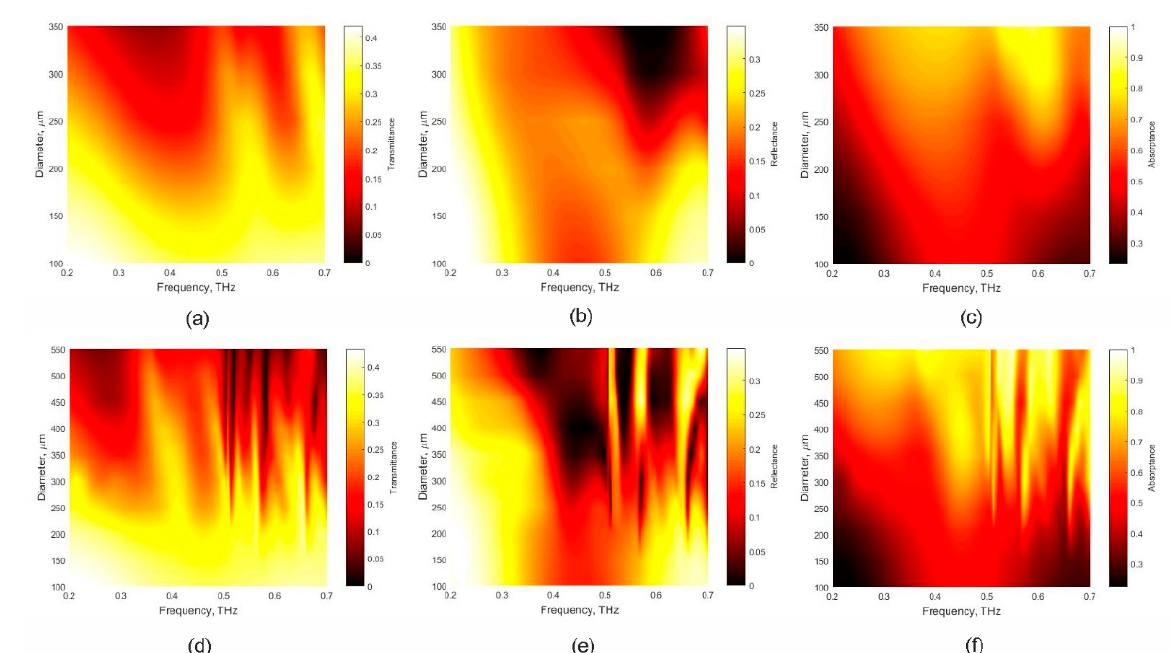
Figure 1. Transmittance ( T ), reflectance ( R ), and absorptance ( A = 1 – T − R ) of multilayer system contained the array of polymer hemispheres covered with Ni layer (30 nm thick) and deposed on SiO 2 substrate versus hemispheres diameter and frequency. The calculations were performed for the structure organized in the square lattice with 400 μ m ( a – c ) and 600 µ m ( d – f ) period, respectively. The following parameters were used in the simulation: the polymer dielectric permittivity was 2.3; the dielectric permittivity of SiO 2 substrate was set 2.7.